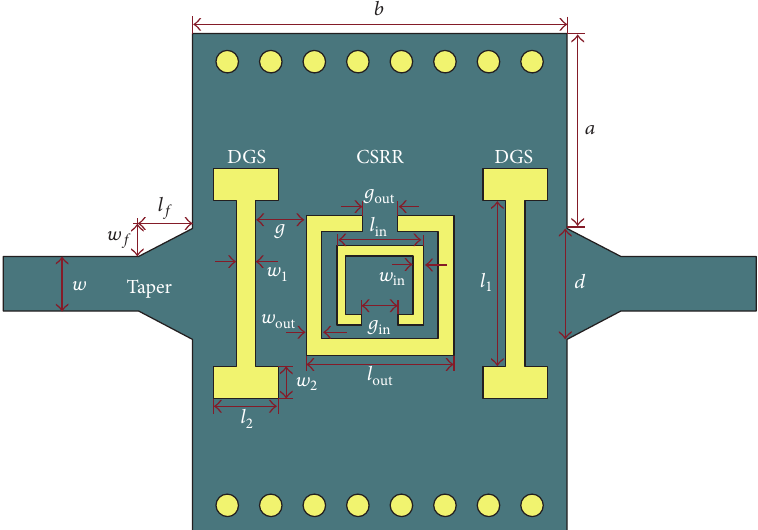
Figure 6: The topology of the proposed filter.